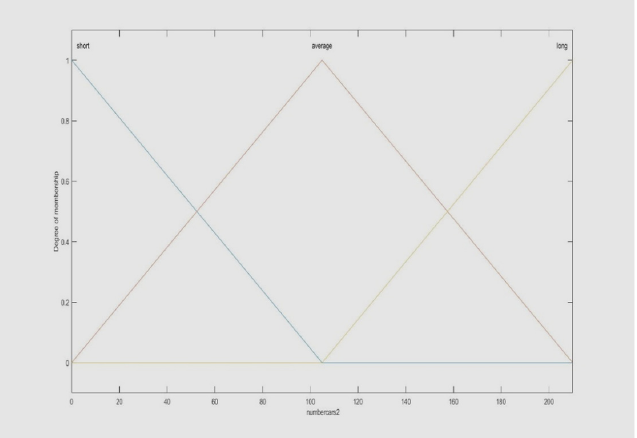
Figure 7. Second input to fuzzy controller for junction 2 with three linguistic values.